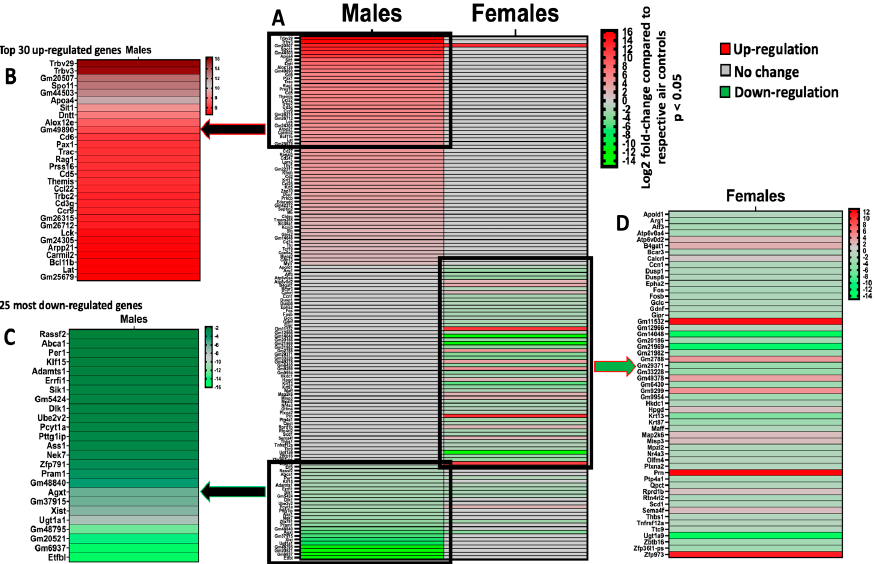
Figure 1. Prenatal exposures to vanilla-flavored e-cig aerosols alter the developing mouse lung transcriptome at birth. The significantly dysregulated genes obtained through RNA sequencing in the lungs of male and female mouse offspring at birth. ( A ) Heatmap of all significantly dysregulated genes in both male (88 genes) and female (65 genes) mouse offspring exposed in utero to vanilla- flavored e-cig aerosol compared to respective air controls. ( B ) Insert displaying the top 30 most up- regulated genes in male mouse offspring. ( C ) Insert displaying the 25 most down-regulated genes in male mouse offspring. ( D ) Insert displaying 55 dysregulated genes in female mouse offspring. Red = up-regulation; green = down-regulation. Values are presented as fold-changes compared to respective air controls. All genes displayed are expressed as Log 2 |fold-change| > 1.5 with a p -value < 0.05. N = 4 per group.